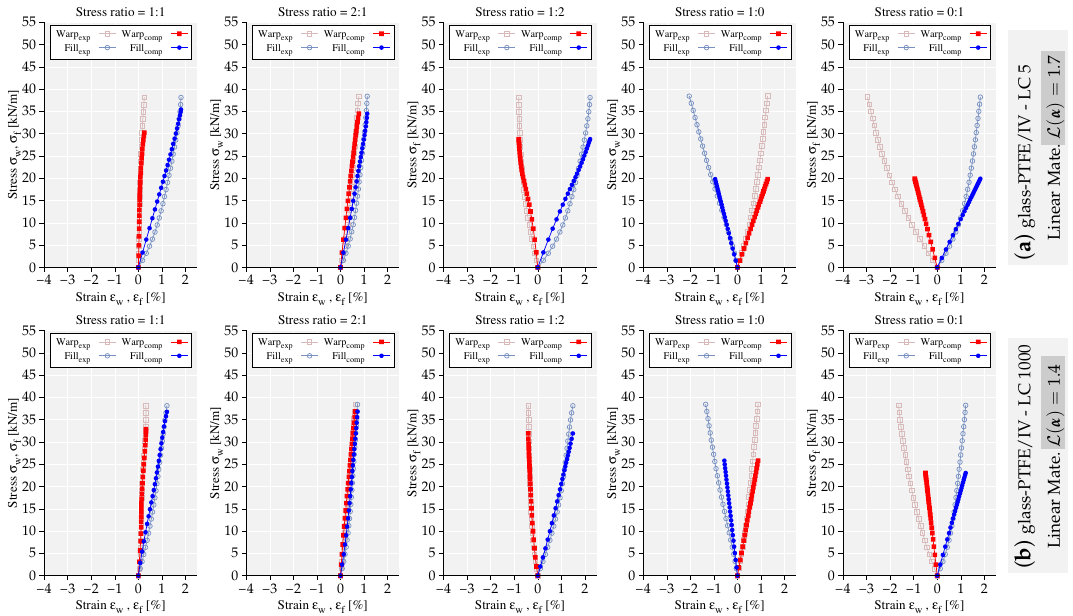
Figure 4. Mechanical response of the linear material model fitting the stress–strain paths of glass-PTFE/IV ( a ) LC 5, ( b ) LC 1000. The obtained error value